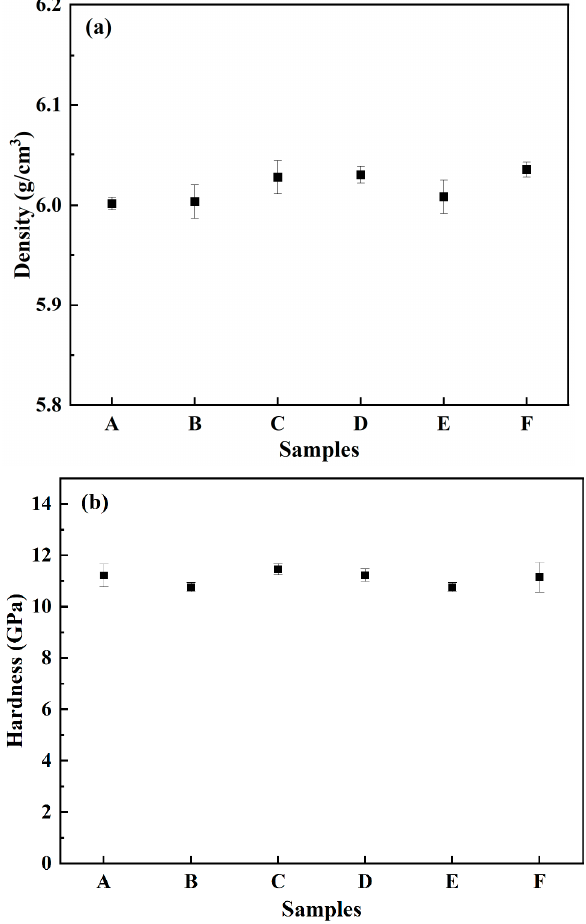
Figure 7. Densities ( a ) and hardness ( b ) of sintered samples with different coupling media at 1575 °C for 2 h.